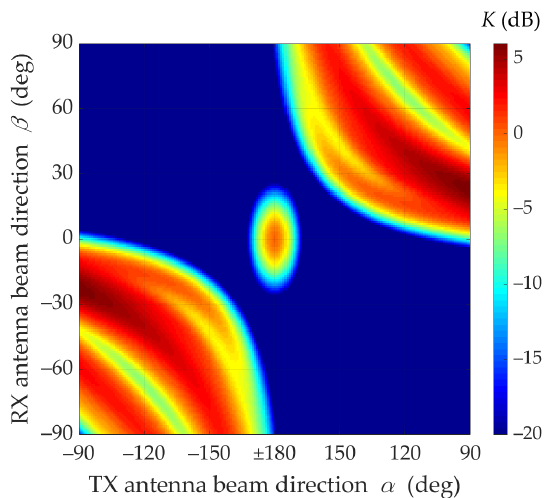
Figure 6. Relative power factor K ( α , β ) versus α and β directions of transmitting and receiving beams under NLOS conditions (3D graph).